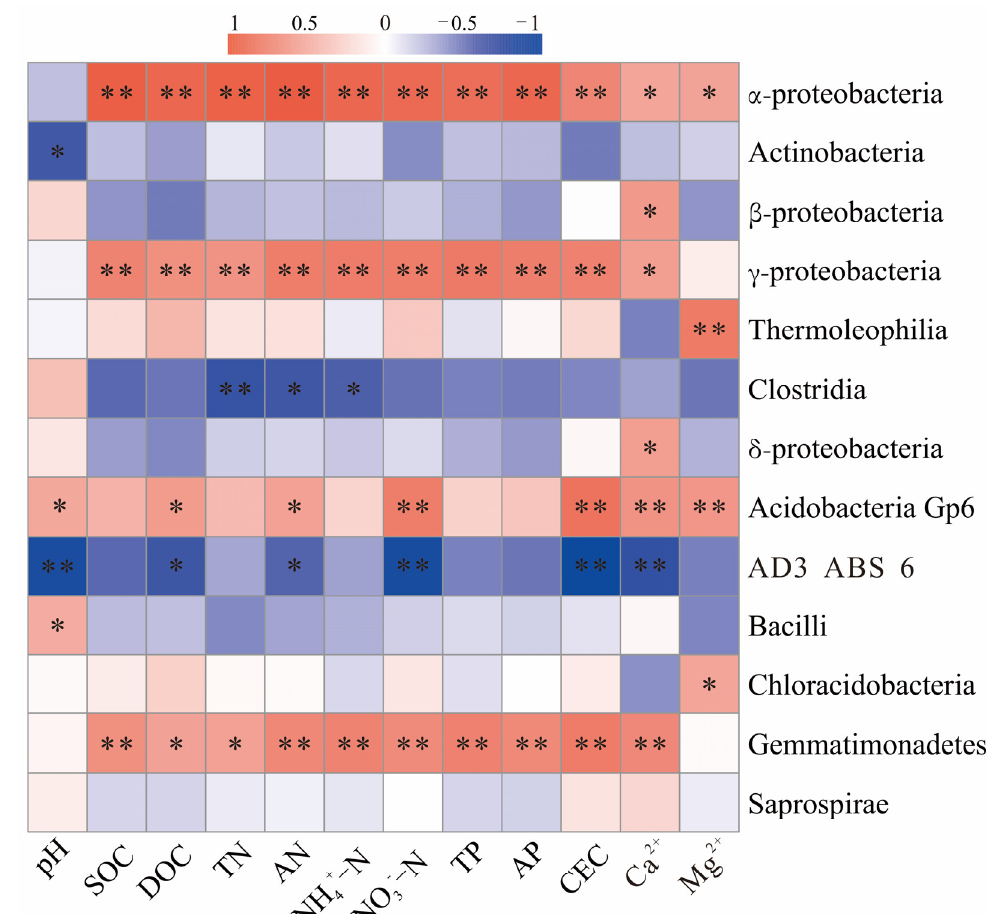
Figure 5. Correlations of dominant classes and soil physicochemical properties. * p < 0.05 (Pearson correlation, two-tailed), ** p < 0.01 (Pearson correlation, two-tailed).